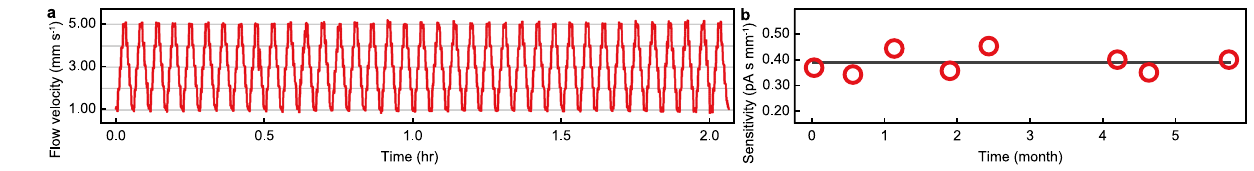
Fig. 3 Repeatability and stability of the graphene device. a The measured fl ow velocity in response to a stepwise fl ow waveform switching between 1, 2, 3, 4, and 5 mm s − 1 , which are represented by the eye-guiding gray solid lines, every 20 s in turn. b Long-term (half-year) stability of sensitivity. The sizes of the error bars (the sensitivity standard deviations based on the uncertainties in current determination over 1-Hz bandwidth) are smaller than the size of the data points. The black line is a constant fi t to the data.